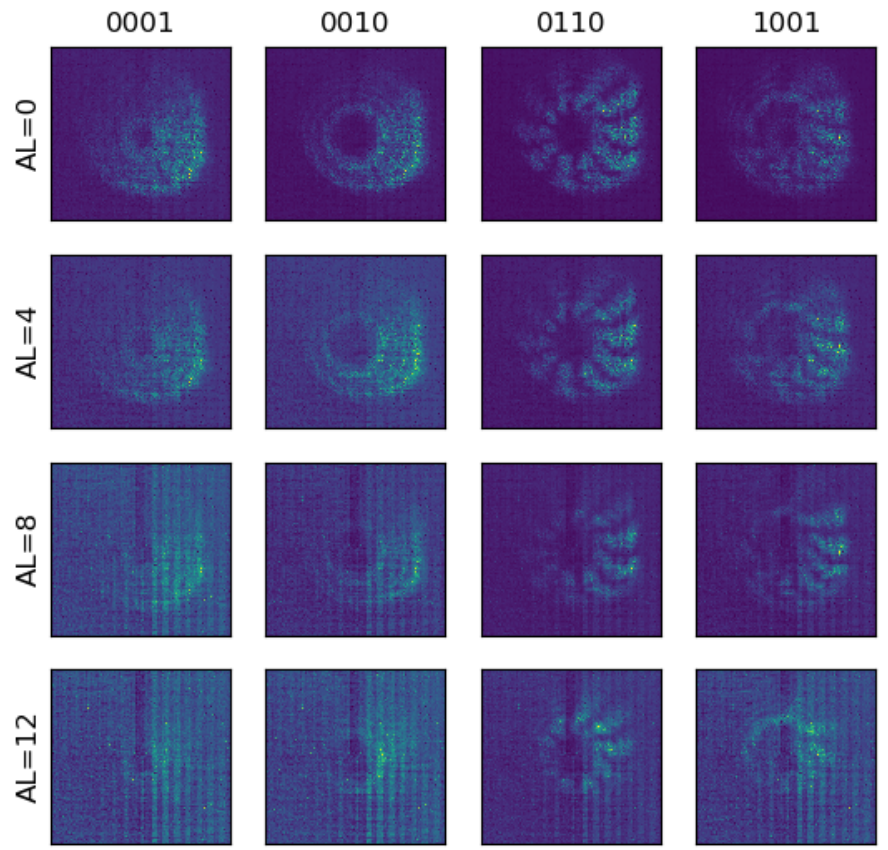
Figure 6. Example of different attenuation levels from the underwater data set. Column header indicates the pattern number and the row label indicates the attenuation